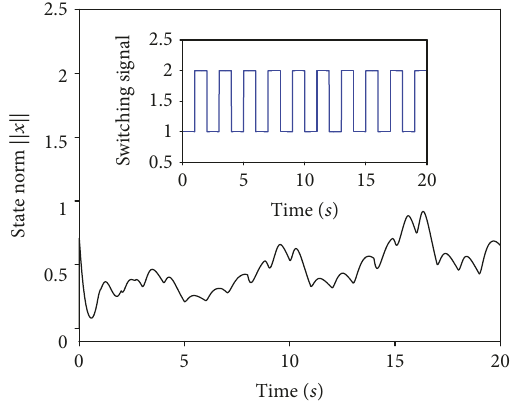
Figure 8: State responses of subnetwork 2 of the considered SNNs for Example 2.